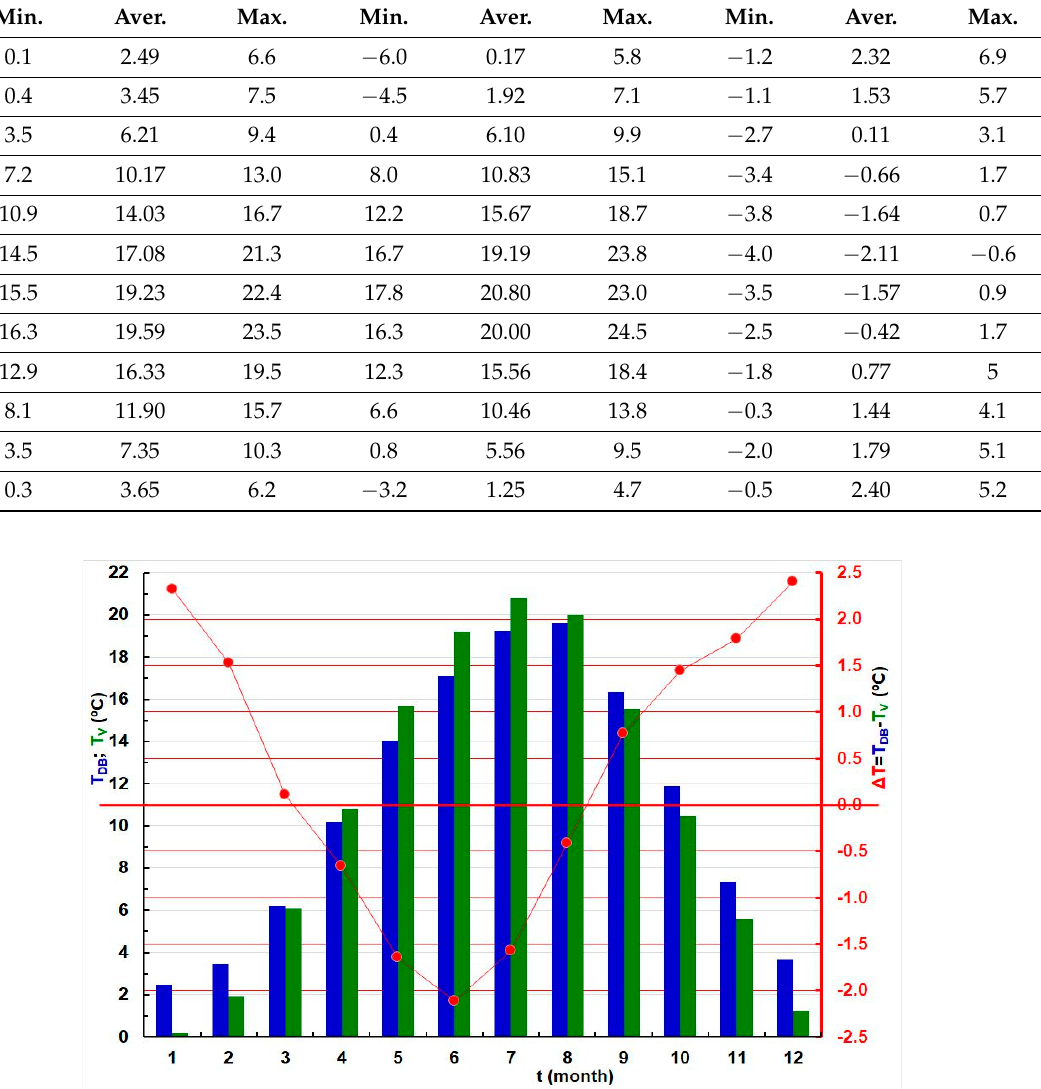
Table 4. Characteristic monthly values (minimum, average, and maximum) of the series of mean monthly water temperatures of Drava Botovo, T DB , the series of mean monthly air temperatures of Varaždin, T V , and the series of their differences, Δ T = T DB − T V , from 1969–2021. T DB T V Δ T Min. Aver. Max. Min. Aver. Max. Min. Aver. Max.